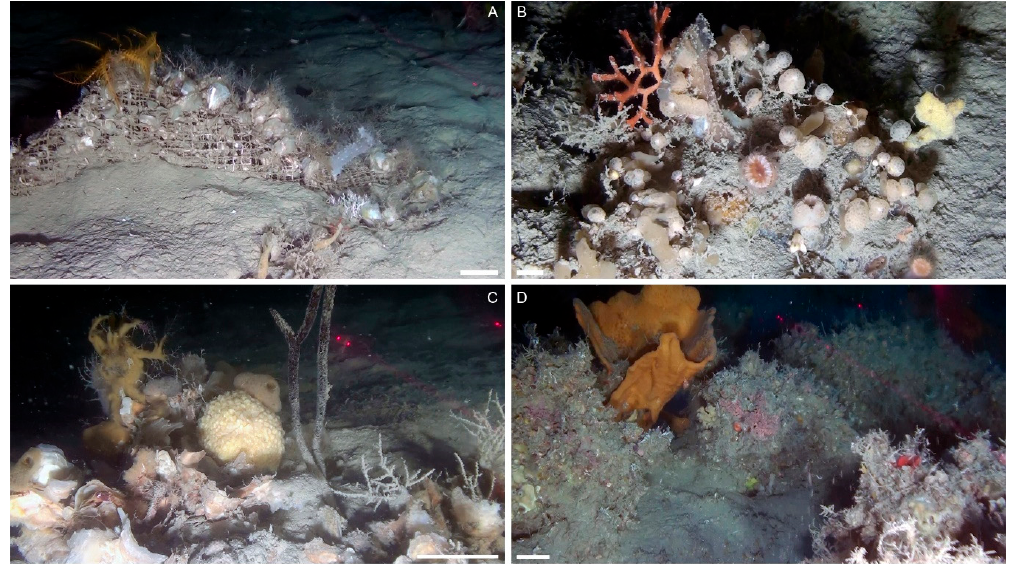
Figure 4. Examples of biodiversity of Neopycnodonte cochlear reefs. ( A ) Cluster of N. cochlear growing on a lost fishing net with Antedon mediterranea (left side) and Alcyonium palmatum (Monopoli); bar = 3 cm. ( B ) Caryophyllia sp., Smittina cervicornis and undetermined lolli-pop and yellow sponges growing on cluster of N. cochlear at Monopoli site; bar = 3 cm. ( C ) The golf ball sponge Tethya aurantium , protected by the SPAMI directive, is a relatively common record on N. cochlear reef (Bonaccia) at 83 m; bar = 5 cm. ( D ) A dense N. cochlear reef hosting the large fan-shaped sponge cf. Pachastrella sp. at ca. 120 m (Santa Maria di Leuca); bar = 10 cm.